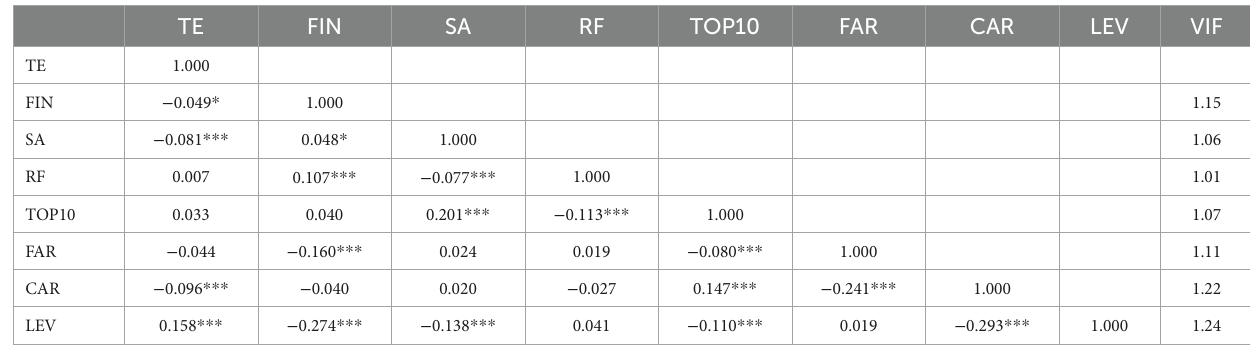
TABLE 3 Relevance analysis.